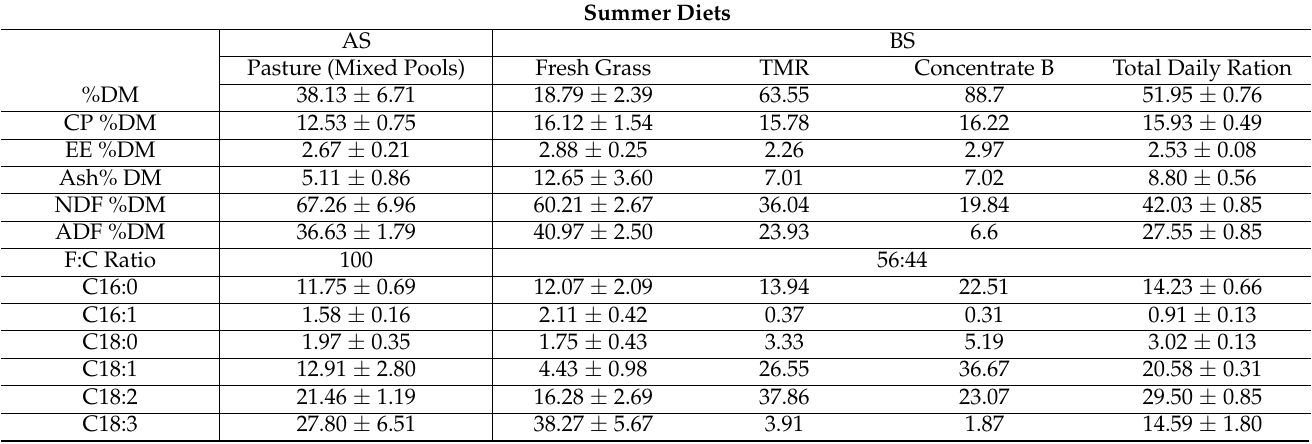
Table 2. Chemical compositions and FA profiles of the summer and winter diets supplied in the two farms (mean values). The chemical composition (CP, EE, ash, NDF, ADF) is presented as the percentage of the dry matter (%DM), while the fatty acid composition is presented as a percentage of the total